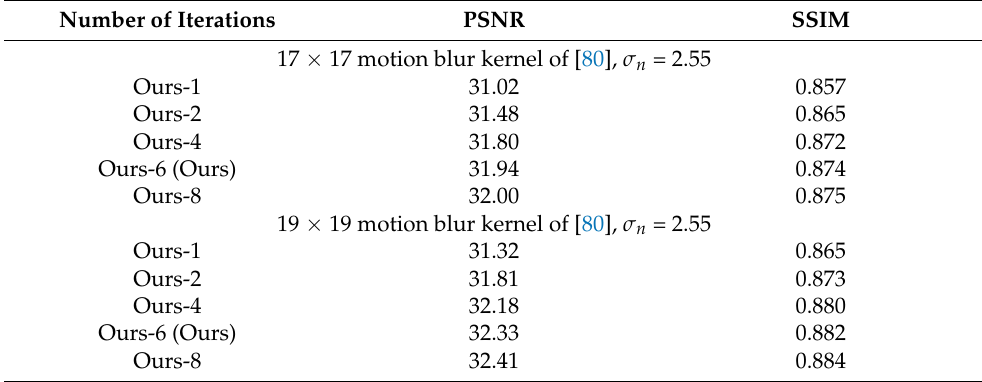
Table 2. The average PSNR and SSIM values of our method with different iteration numbers on the Kodak24 dataset.